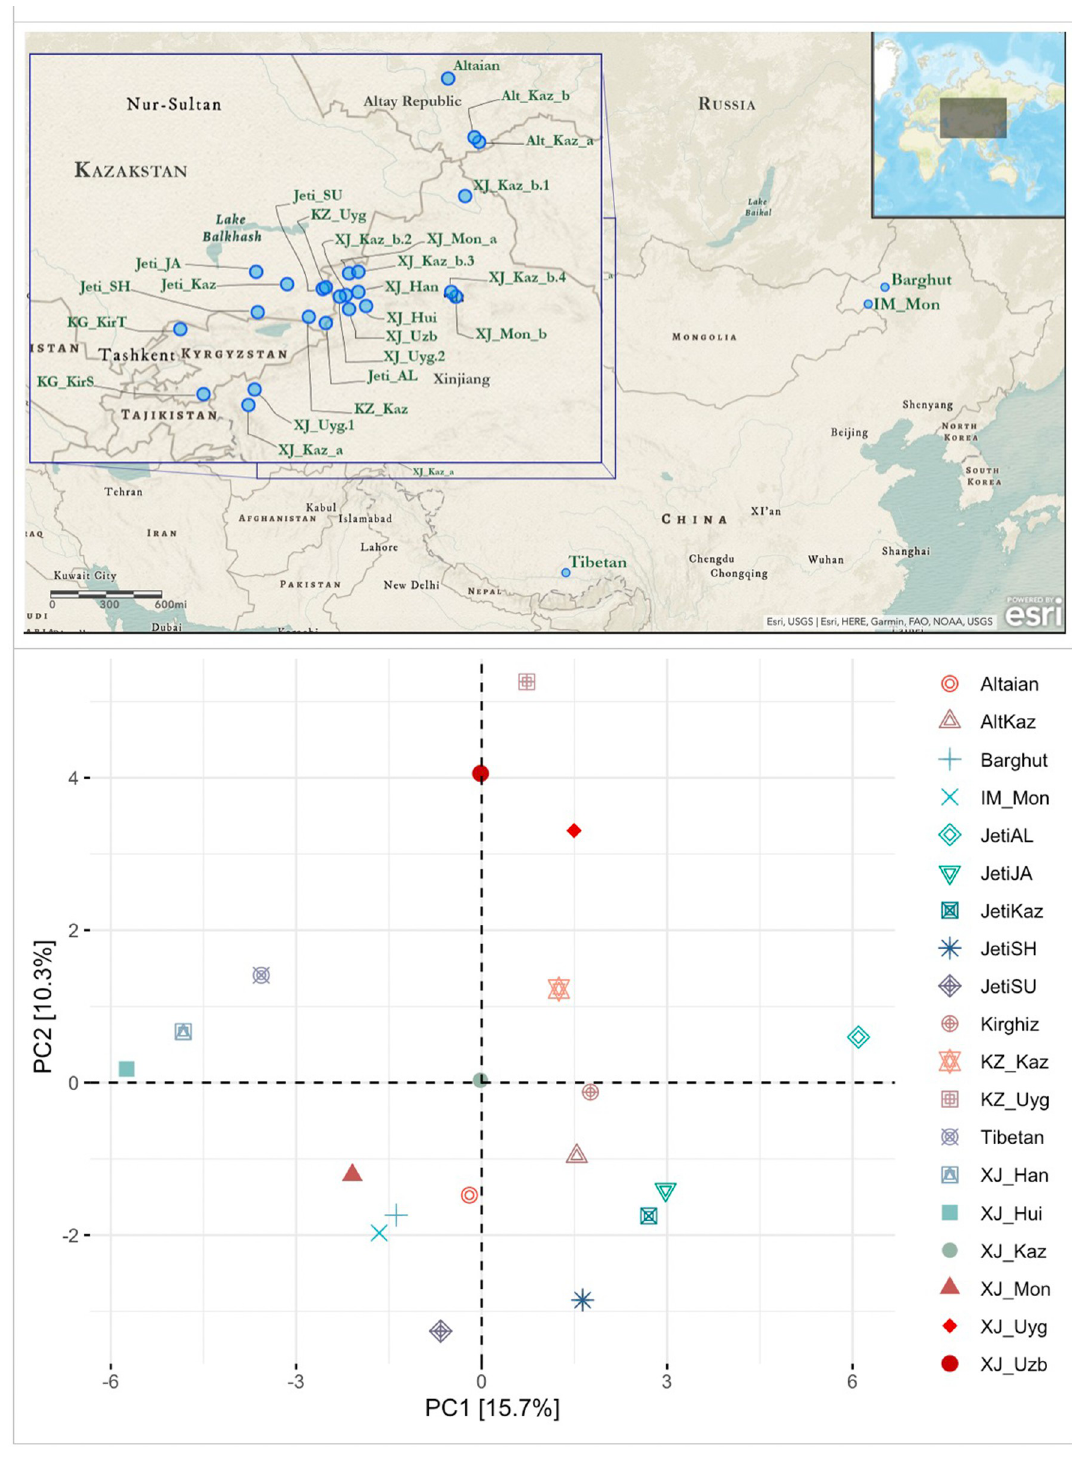
Fig 2. Geographic distribution of the human populations and the mtDNA control region haplogroup frequency based PCA. Notes on Fig 2: Jeti_AL [Alban (N = 35)], Jeti_JA [Jalayir (N = 76)], Jeti_SH [Shapirashti (N = 59)], and Jeti_SU [Suan (N = 26] are the four Kazak populations from Jetisuu, Kazakhstan; Jeti_KZ [Four populations from Jetisuu combined, plus 4 individuals with ambiguous clan identity (N = 200)]; Altaian [Altaians (N = 490) from the Altay Republic, Russia] [25]; AltKaz_a [Kazaks (N = 237) from the Altay Republic, Russia] [12]; AltKaz_b [Kazaks (N = 98) from the Altay Republic, Russia] [15]; Barghut [Barghuts (N = 149)